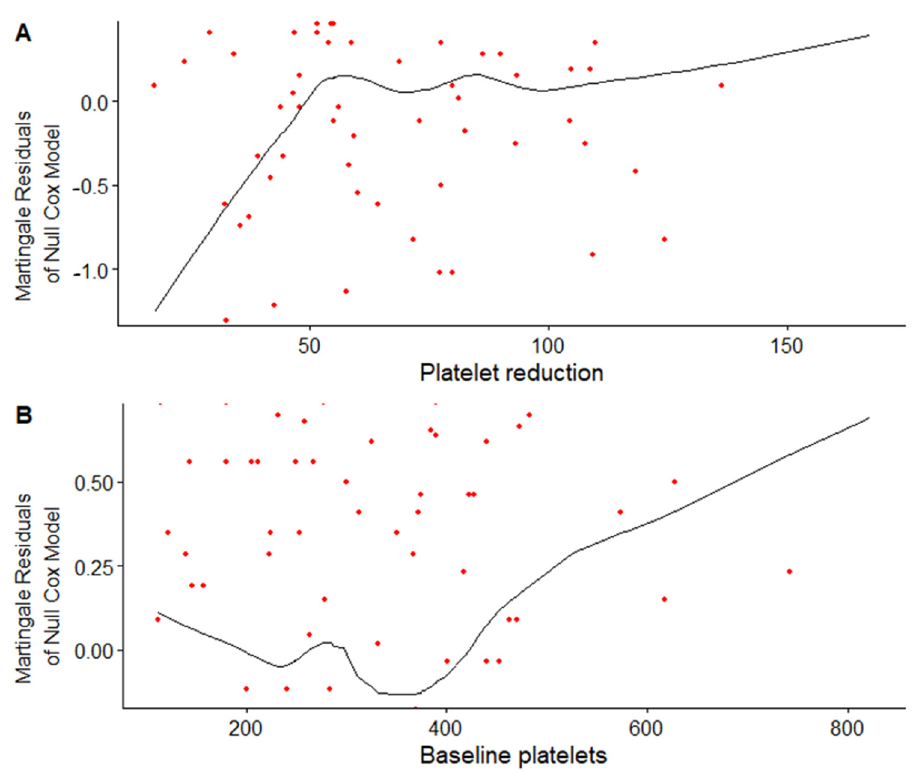
Figure 1. Relationship between PLT-red, PLT-count, and overall survival. ( A ) Martingale residuals of the null Cox model plotted against PLT-red. ( B ) Martingale residuals of Null Cox model plotted against PLT-count. The superimposed smooth line shows the approximation of the true functional form of a given covariate. The increasing trend shows shorter OS.